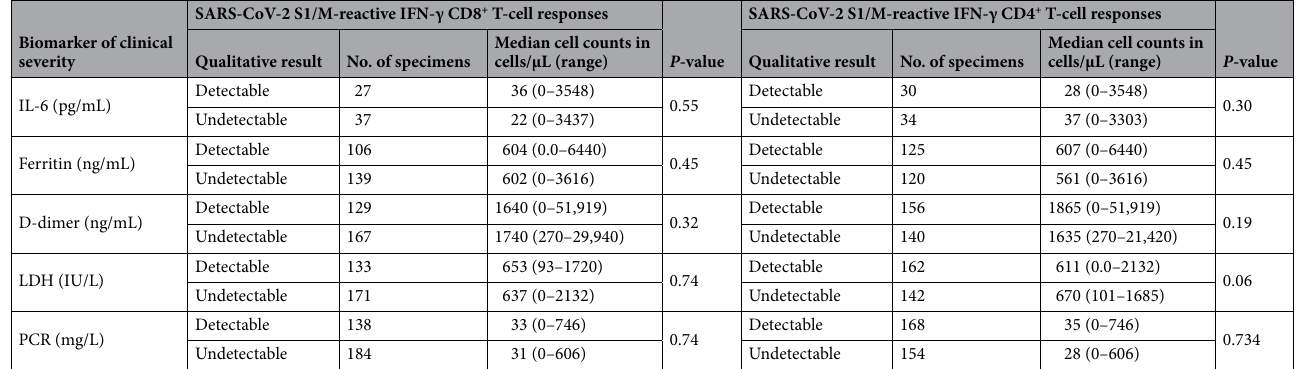
Table 3. SARS-CoV-2 S1/M-reactive IFN-γ CD8 + and CD4 + T-cell counts in whole blood and serum levels of clinical severity biomarkers in critically ill patients.